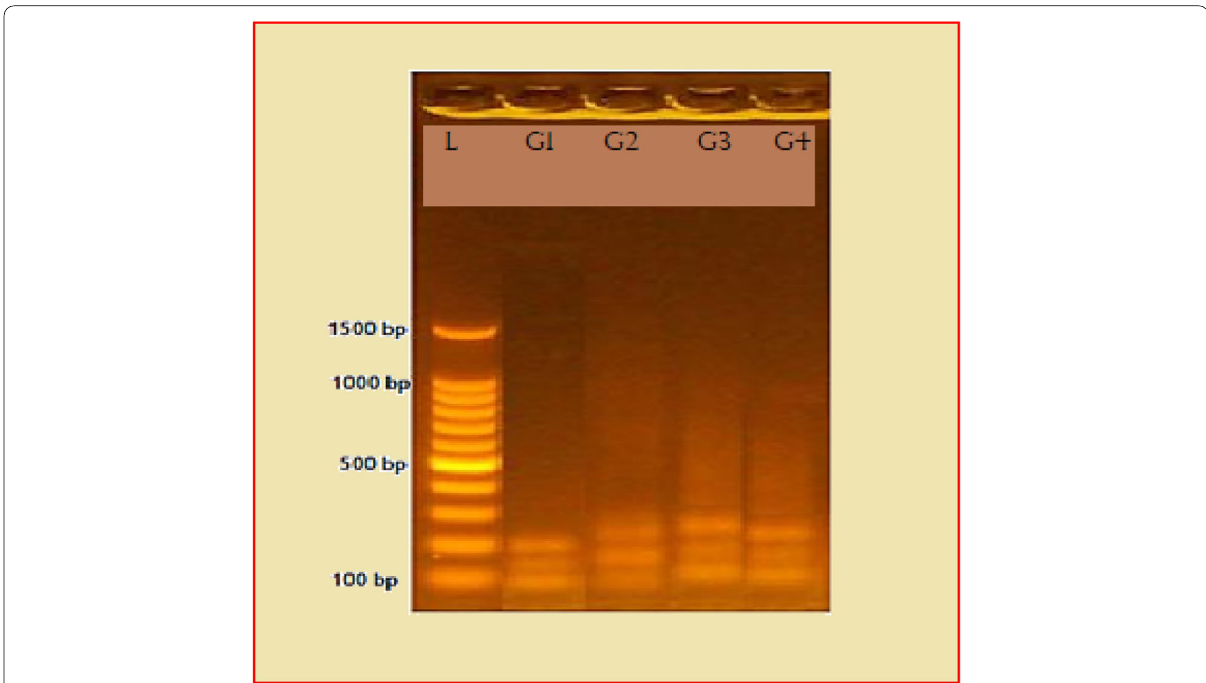
Fig. 1 Agarose electrophoresis of multiplex PCR product using hot start Promega master mix. G1 represented first group (DXS7424, HPRTB, and DXS8377) gave PCR product size (100\150\200)bp; G2 represented second group (GATA31E08, DXS 7423, and DXS 8378) gave PCR product size (115\175\225)bp; G3 represented third group ( DXS9895, DXS10074, and DXS6809) gave PCR product size (125\185\250); G4 represented fourth group ( DXS7133, DXS101, and DXS6807) gave PCR product size (115\175\225)bp on 2.5% agarose at 70 V for 90 min (5 μl of PCR were loaded in each